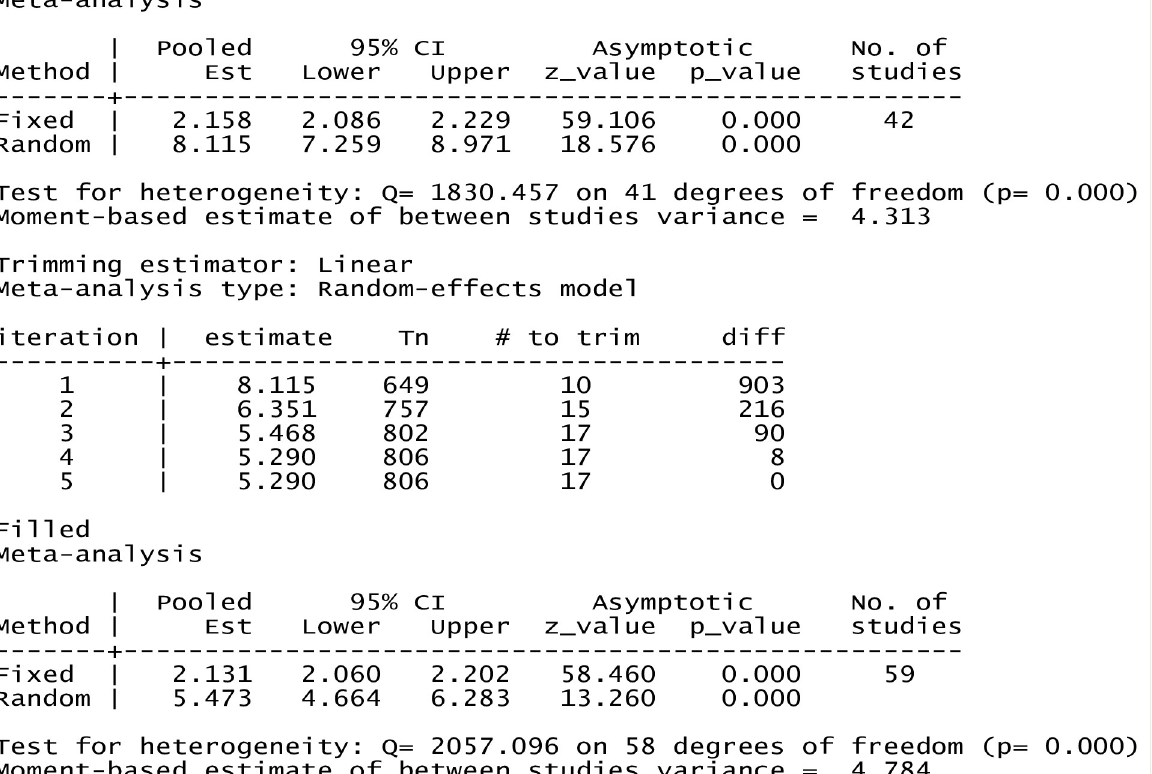
Fig 5. Trim and fill analysis for the prevalence of cervical cancer screening service